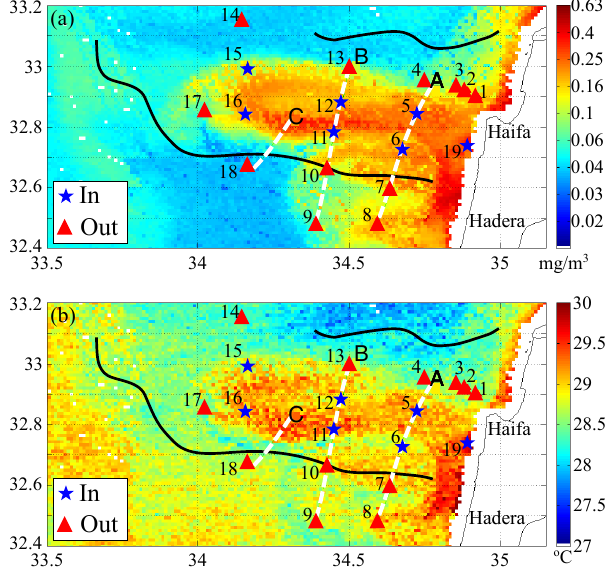
Fig. 3. Sea surface (a) chlorophyll a and (b) temperature associated with the intrusive patch observed on 22 August 2011. Solid black lines mark the attracting LCSs constraining the patch from the north and from the south. Dashed white lines mark the sections presented in Fig. 4. The letters A, B and C denote the sections delimited in Fig. 4a–c, respectively. Blue stars and red triangles represent the locations of sampling stations in and out of the patch, respectively (location of the stations with respect to the patch is defined accord- ing the sections in Fig. 4). Numbers denote station